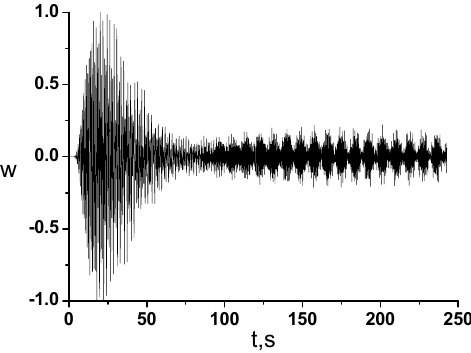
Figure 7. The scaling factor is equal to 3.